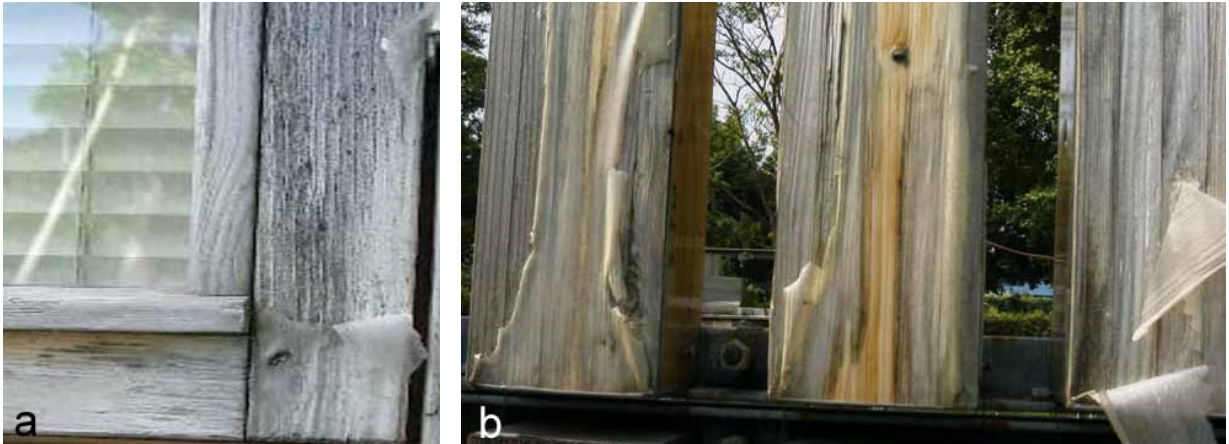
Figure 4. Peeling and delamination of clear coatings on wood due to photodegradation of wood beneath the coating: ( a ) Clear coating peeling from a vertical window casing in a private house in southern France. Note the fungal staining of wood beneath the clear coating; ( b ) Fluorine resin-based clear coating peeling from glulam test specimens exposed to the weather in